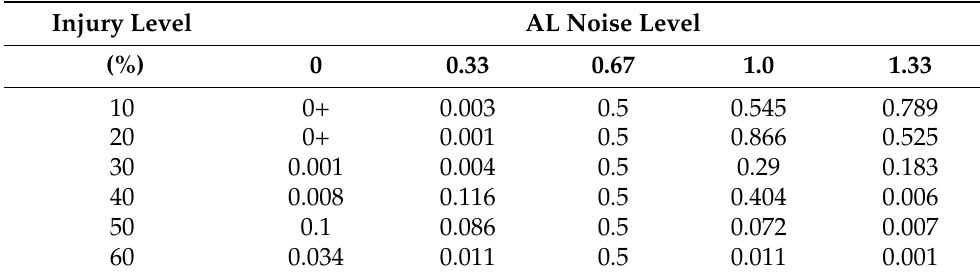
Table A3. P -values for normalized post-training effects of increased AL noise on top-scoring responses (see Figure 6B). p -values are for a given AL noise vs. AL noise = 0.67 (i.e., the middle value). “0+” indicates p -value < 0.0005. N = 31 to 40 (mean =